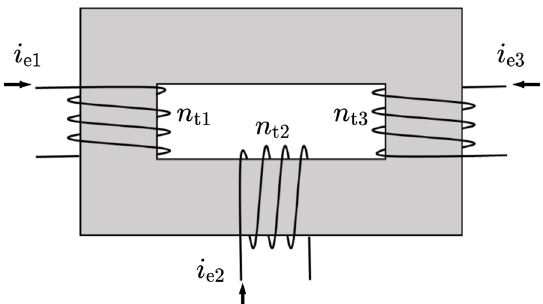
Fig. 11 Core magnetic structure under consideration